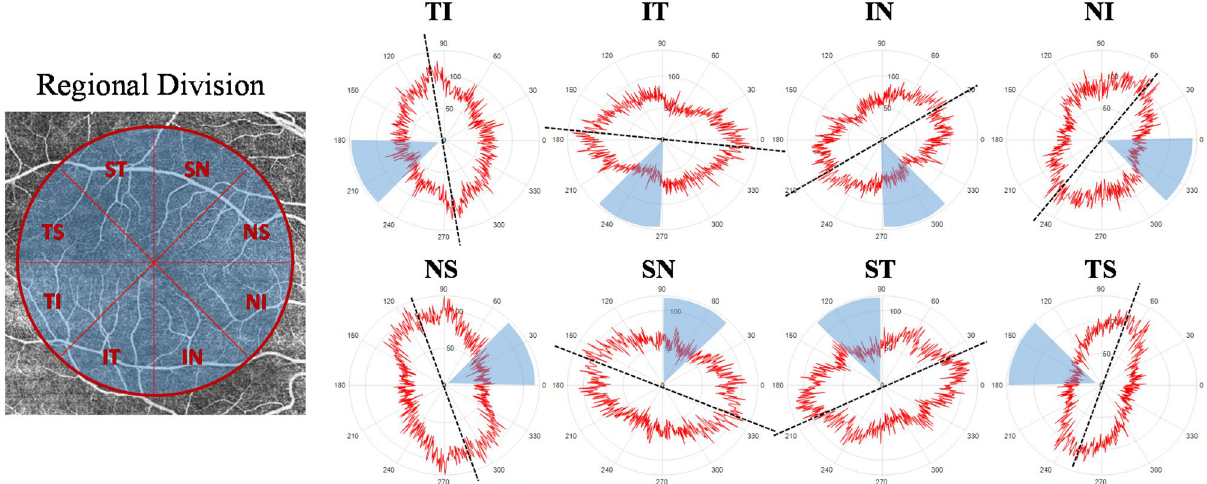
Figure 5. Sectoral vascular pattern with preferred vessel orientation (dashed line) unaligned with sector axis. Eight 45º sectors were divided from a circular disk centered at the macula and each sector was defined as the region of interest for the quantitative assessment of retinal vascular orientation pattern. N nasal, S superior, T temporal, I inferior.